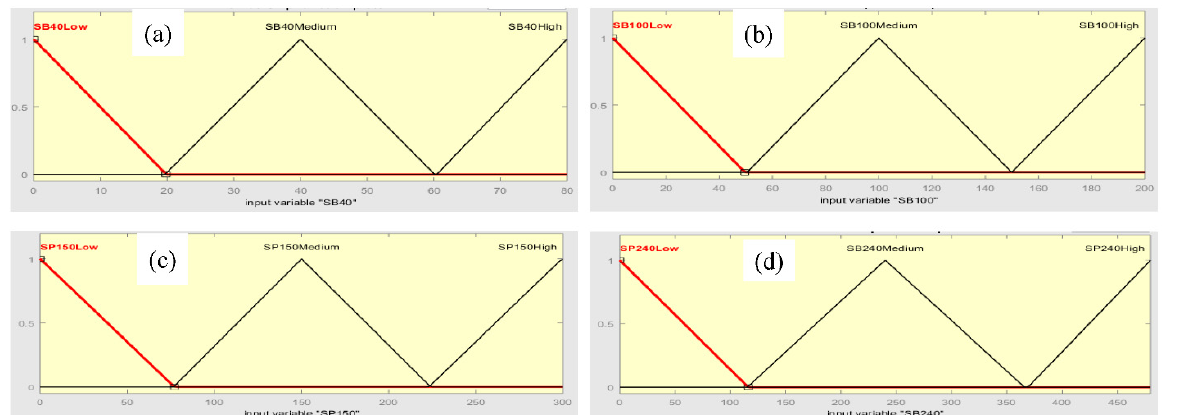
Figure 9. Triangular membership functions for fuzzy system inputs ( a ) SB 40, ( b ) SB 100, ( c ) SP 150, and ( d ) SP 240. Table 3. Membership Functions of Fuzzy System Inputs.